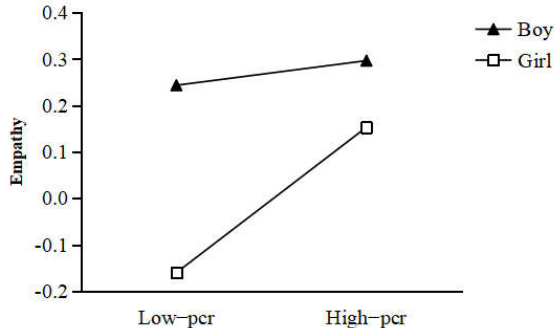
Figure 3. The moderating effect of gender on the relationship between the parent–child relationship and empathy. Note. pcr = parent−child relationship.